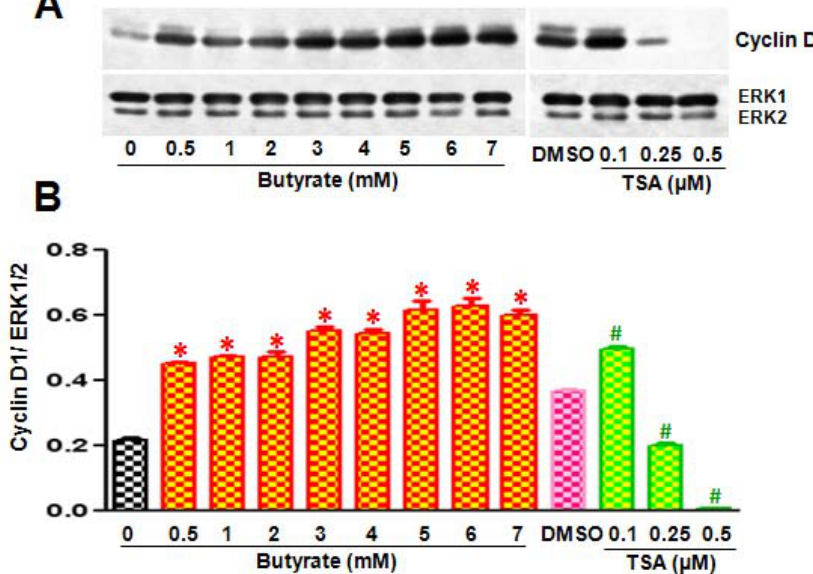
Figure 3. Disparate effects of butyrate and TSA on cyclin D1 expression in VSMC. Proliferating VSMC were treated with different concentrations of butyrate or TSA for 48 h and then cell lysates were prepared and processed for western analysis of cyclin D1. ( A ) Western blots were probed with cyclin D1-specific antibody and band intensities of cyclin D1 were determined and quantitated using a Molecular Imager FX Pro Plus MultiImager system and Quantity one software (Bio-Rad, CA, USA); ( B ) Band intensities are normalized to ERK1/2 as shown in bottom panel. Data are presented as mean ± S.D. of three independent experiments. * p < 0.0001 vs. no addition control (Con); # p < 0.0001 vs. DMSO vehicle control by ANOVA with the Bonferroni